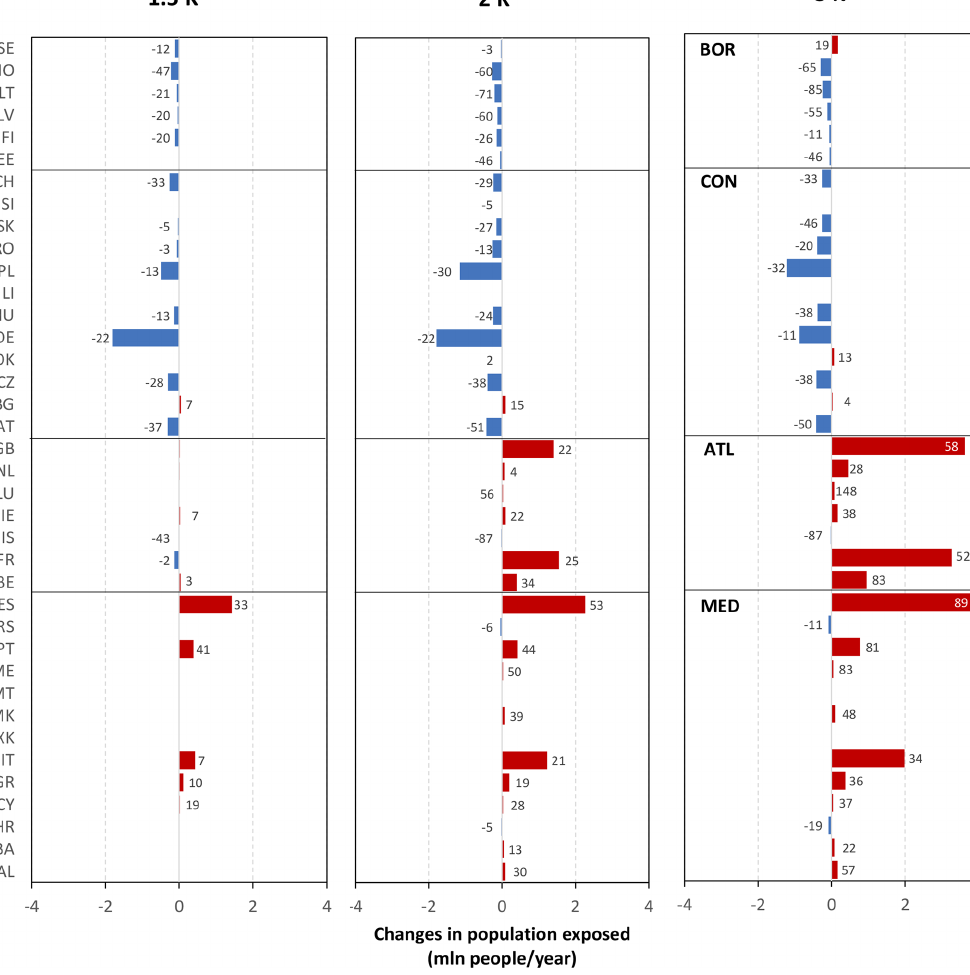
2009; Stahl et al., 2012; Forzieri et al., 2014) or on